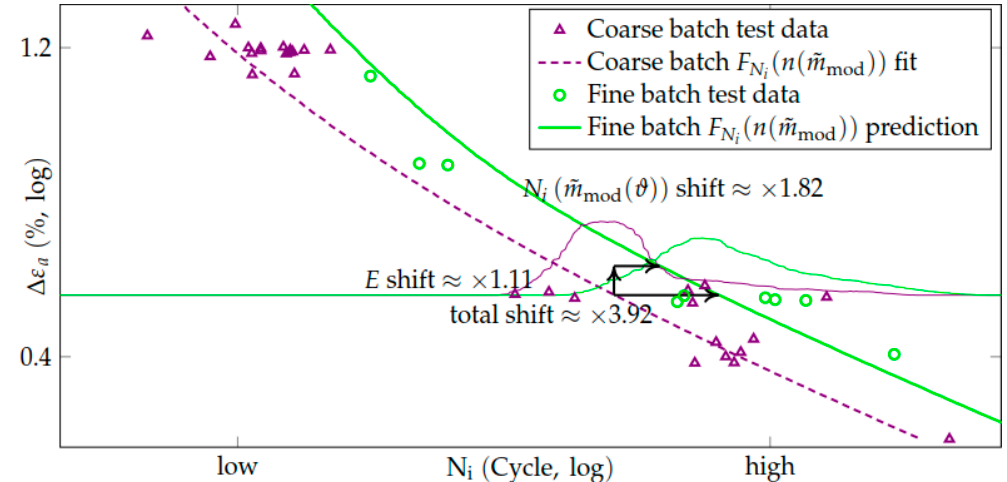
Figure 16. Fit and prediction curve for the CMB with modified Schmid factor distribution model.